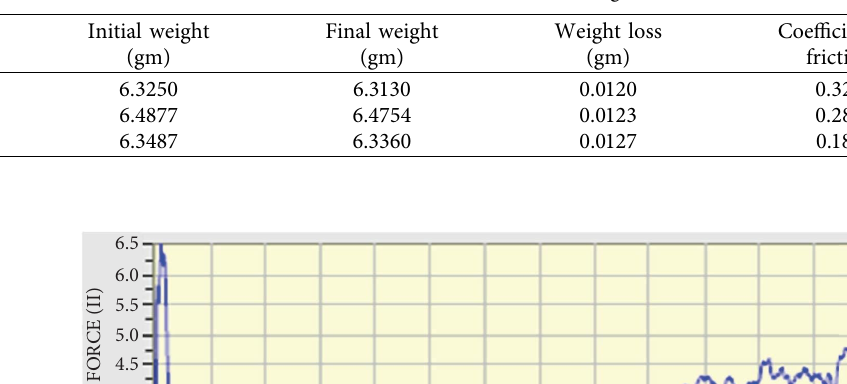
Table 3: Wear test readings.